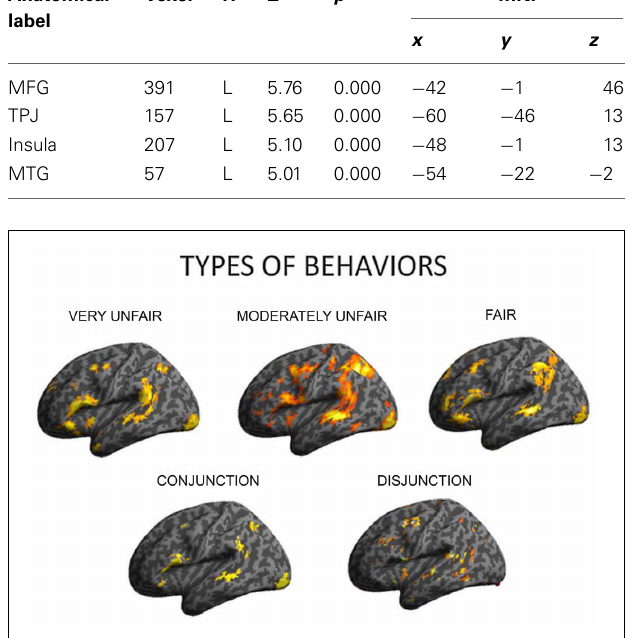
Table 4B | Interaction effects (disjunction between unfair + mid vs. fair offers).